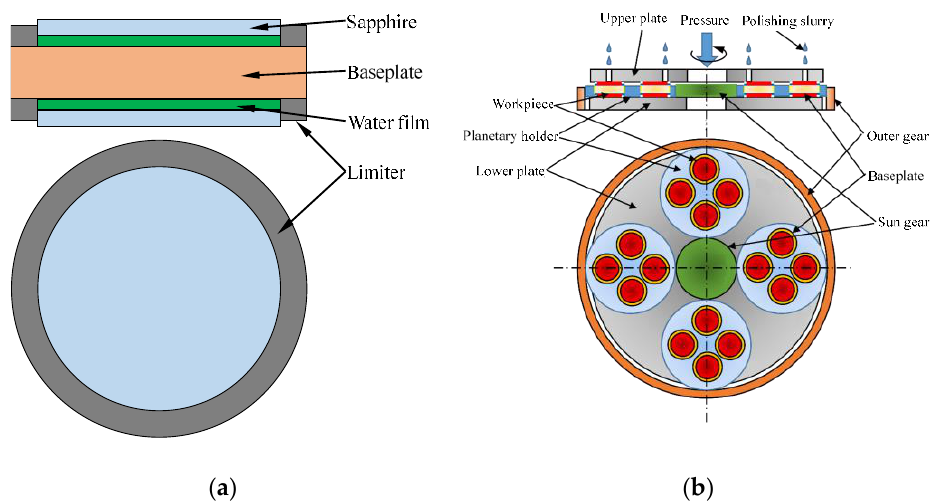
Figure 1. Schematic diagram of double-sides processing by layer stacked clamping (LSC) method: ( a ) principle of layer stacked clamping; ( b ) schematic diagram of layer stacked double-sides processing.